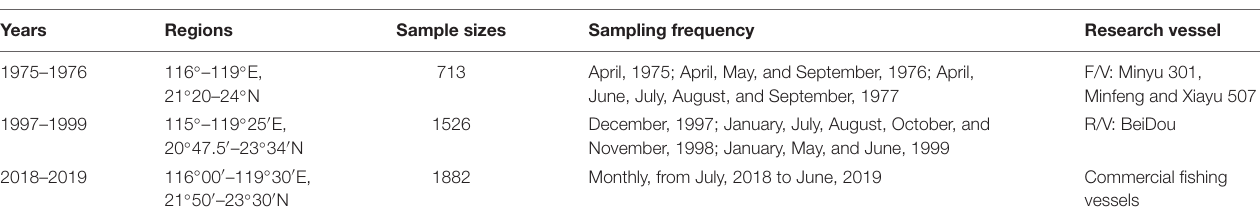
FIGURE 1 | Study area in the northeast South China Sea and the current systems [Redrawn from Cai and Shi (2009) and Hu et al. (2010)]. TABLE 1 | Sampling areas, sample sizes, and sampling frequency in different